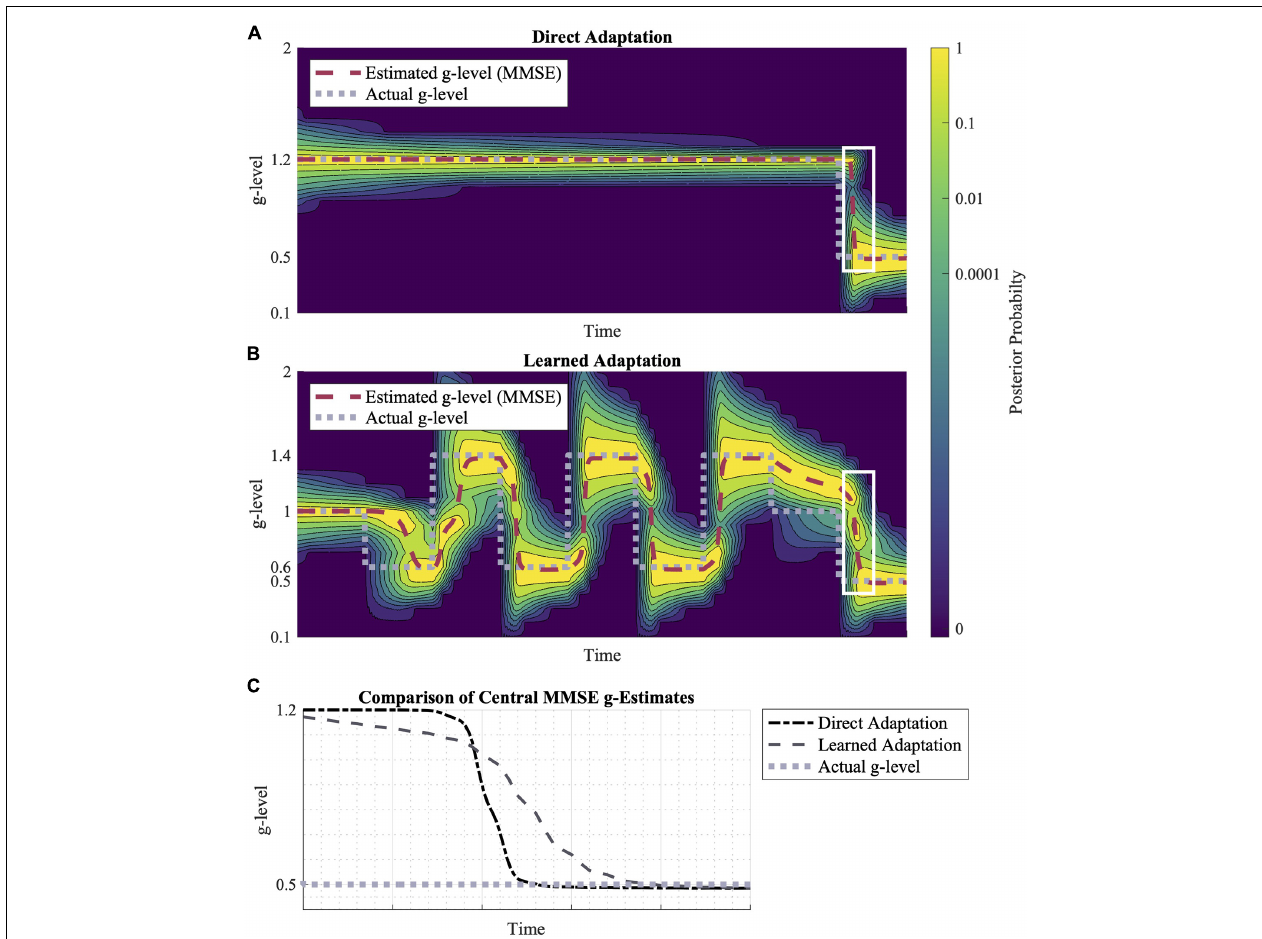
FIGURE 6 | Direct adaptation vs. learned adaptation scenarios. (A) Direction adaptation from 1.2 to 0.5 g . (B) Learned adaptation using oscillating “training” gravitational levels to create a wider probability distribution leading to a final gravity level of 0.5 g . (C) A closer look at the white highlighted regions in (A,B) , shows their relative adaptation rates to 0.5 g . While the learned adaptation scenario begins adapting first, the direct adaptation converges to 0.5 g faster. Inputted motion profiles were sinusoidal, head-centered roll-tilt (amplitude, 30 ◦ ; frequency, 0.25 Hz).